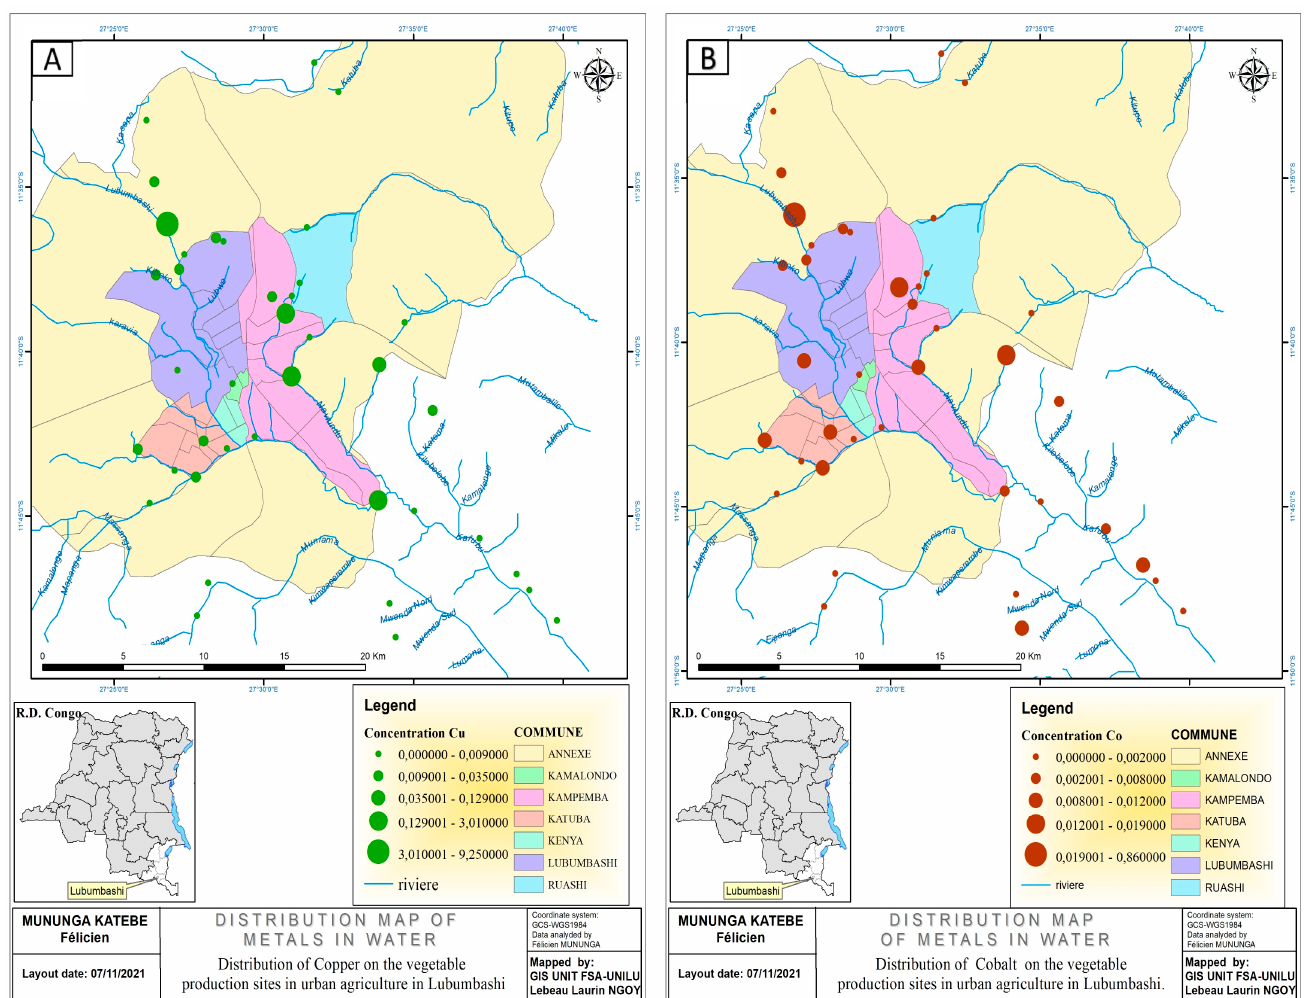
Figure 9. Spatial distribution of metals (Cu and Co) in the waters of Lubumbashi market gardens.